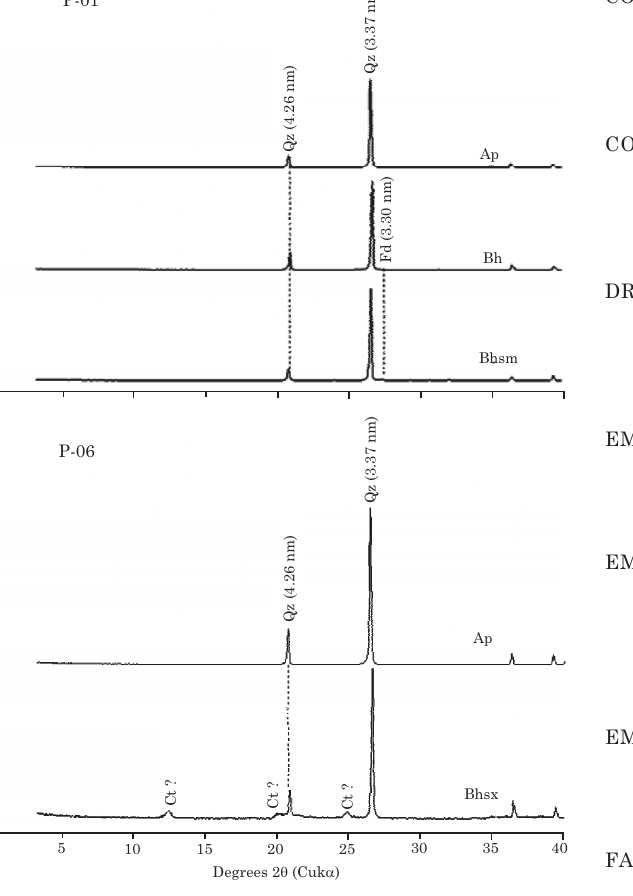
Figura 4. Difratogramas de raios-X da fração areia dos horizontes Ap, Bh e Bhsm, do perfil 1, e dos horizontes Ap e Bhsx, do perfil 6. Ct: caulinita; Fd: feldspato; e Qz: